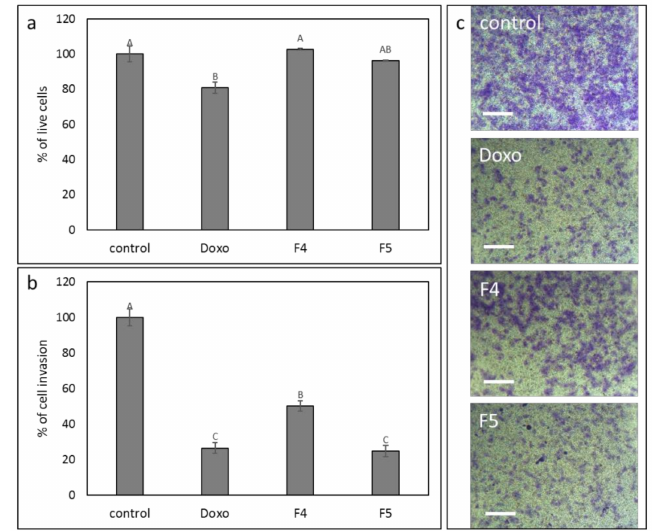
Figure 9. The effect of the F4 and F5 treatments on A172 cell invasion. The vertical movement of A172 cells across the 8 µ m pore size membrane, following treatment with F4 (12 µ g/mL) and F5 (10 µ g/mL) for 24 h. Error bars indicate ± SE ( n = 3). Levels with different letters are significantly different from all combinations of pairs according to the Tukey–Kramer honest significant difference (HSD; p ≤ 0.05). ( a ) Percentage of cell viability; ( b ) percentage of invading cell in comparison to control; ( c ) examples for images of cells that invaded the membrane at 24 h, following crystal violet staining. Scale bars = 500 µ m. Doxorubicin (Doxo, 0.5 µ g/mL) served as a positive control. Control is vehicle control (0.6% v / v